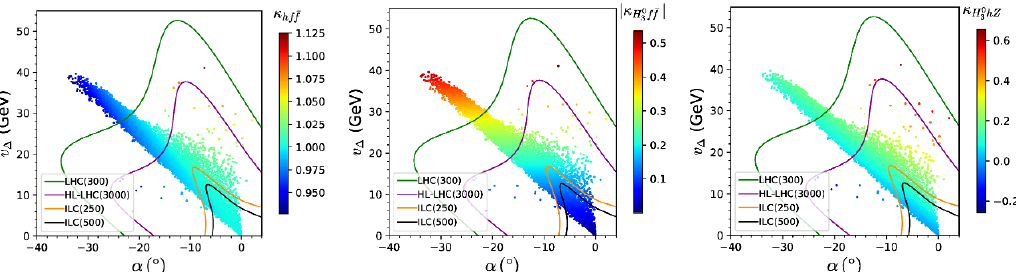
j , and (cid:20) , j (cid:20) in the v (cid:1) (cid:0) (cid:11) plane after imposing all H 0 3 hZ hf (cid:22) f H 0 3 f (cid:22) f